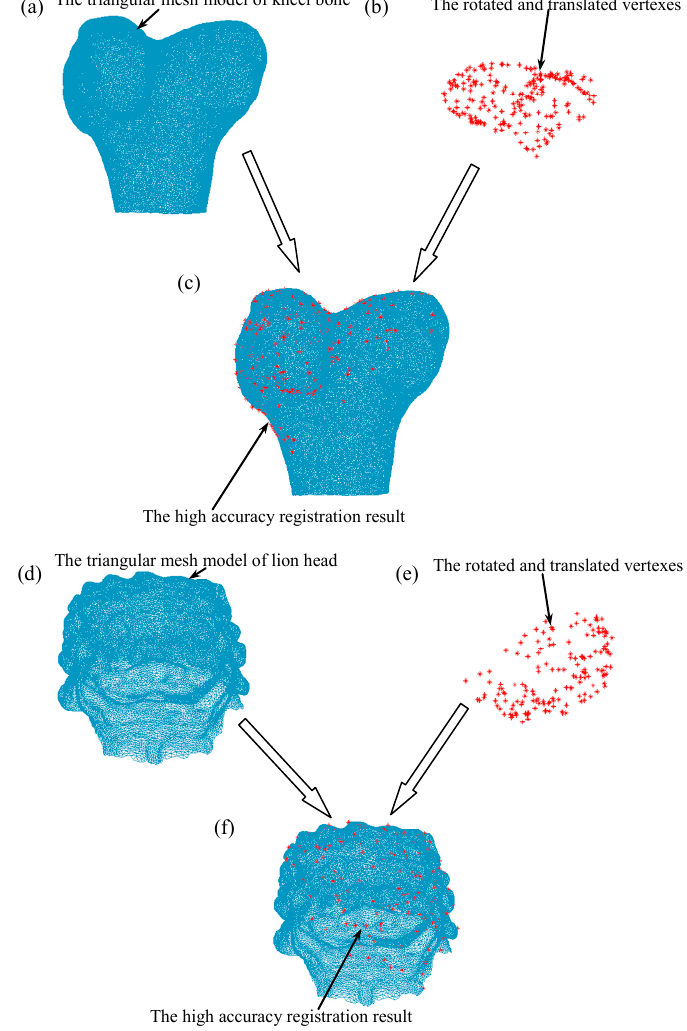
Figure 14. Simulation experiments of knee bone model and Chinese lion model are described, ( a ) the triangular mesh model of knee bone, ( b ) the rotated and translated vertexes of knee bone, ( c ) the registration result of knee bone, ( d ) the triangular mesh model of lion head, ( e ) the rotated and translated vertexes of lion head, ( f ) the registration result of lion head. Appl. Sci. 2017 , 7 , 1092 14 of 16